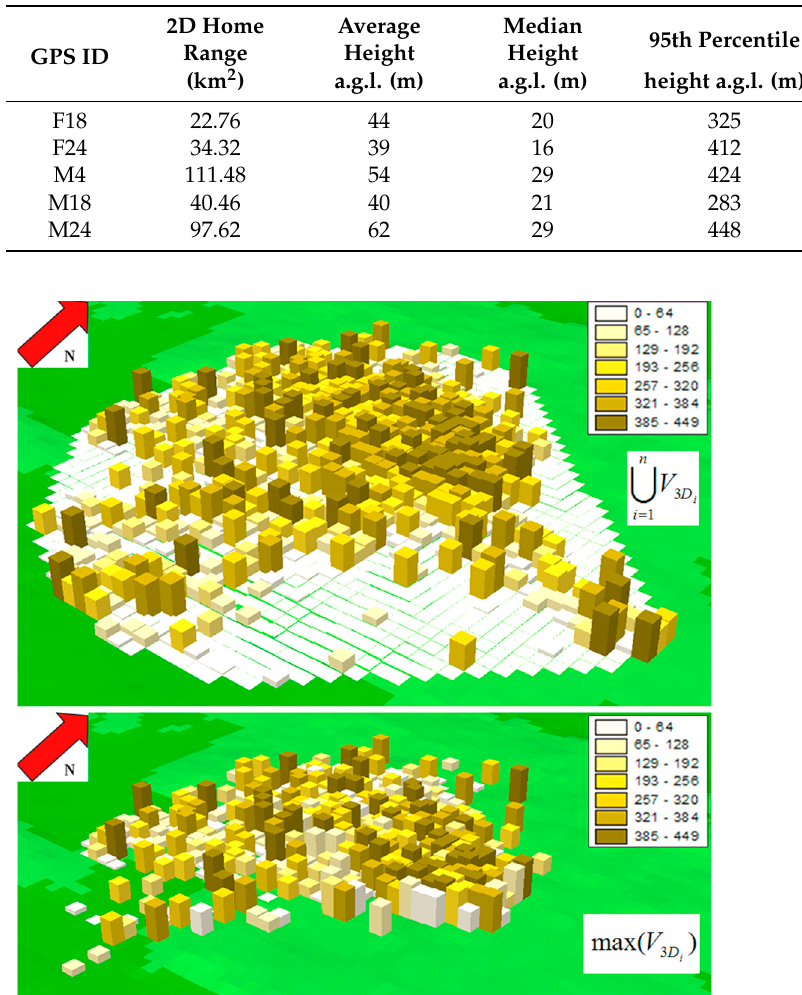
Figure 4. Top: spatial union of the 3D volumetric home ranges of the tracked lesser kestrels (volume = 15.08 km 3 ). Bottom: largest 3D volumetric home range (lesser kestrel ID M24; volume = 8.19 km 3 ). The legends show heights above ground level (in meters) of the parallelepipeds constructed by extruding the 1584 squares of Figure 2.